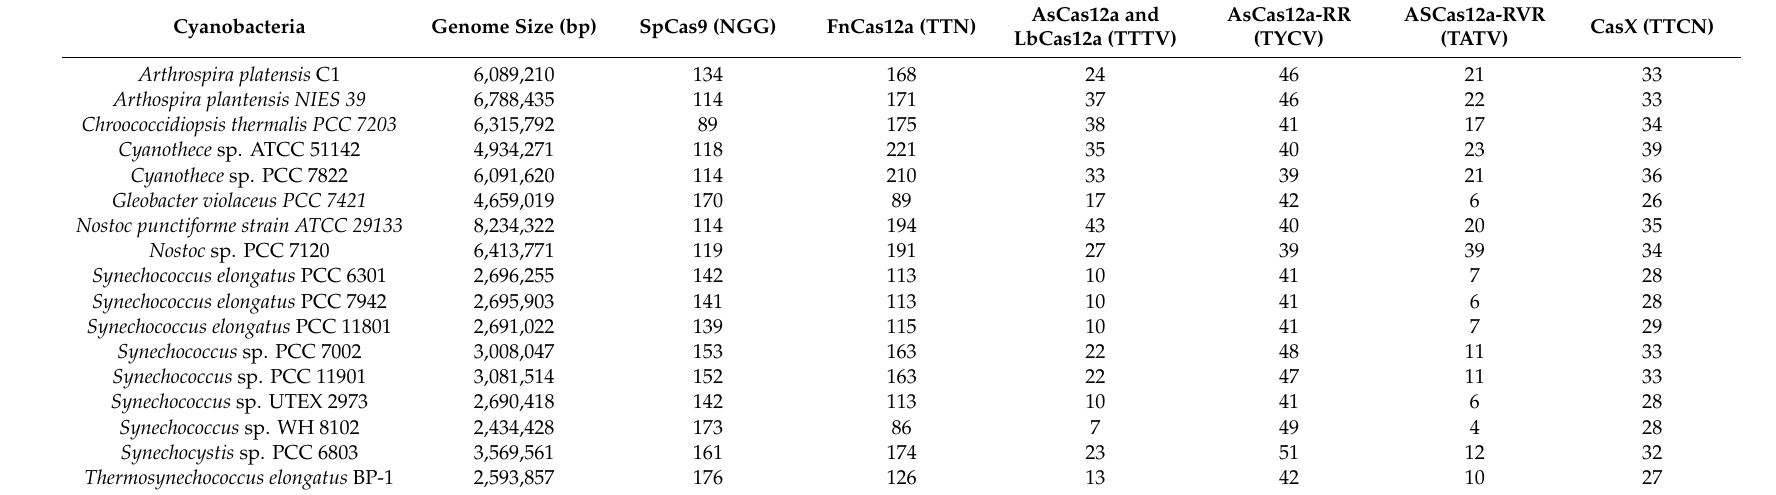
Table 4. The available PAM sequences for cyanobacterial species highlighted in this study for di ff erent Cas variants. Only species with full genomes available are shown. The Cas variants indicated are Streptococcus pyogenes Cas9 (SpCas9), Francisella novicida Cas12a (FnCas12a), Acidaminococcus sp. Cas12a (AcCas12a, and variants AsCas12a-RR and ASCas12a-RVR), Lachnospiraceae bacterium Cas12a (LbCas12a) and Deltaproteobacteria bacterium CasX (CasX). The average number of PAM sites (in brackets) per kb of genome are shown (N = A, T, C, G; V = A, C, G; Y = C, T). Genome data was sourced from The European Nucleotide Archive (https: // www.ebi.ac.uk / ena) and The National Centre for Biotechnology Information (https: // www.ncbi.nlm.nih.gov / genome). Cyanobacteria Genome Size